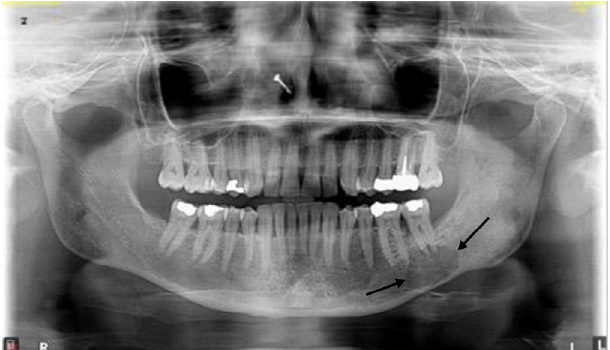
Fig. 1. Orthopantomogram: lytic mandibular bone lesion in the left molar area.